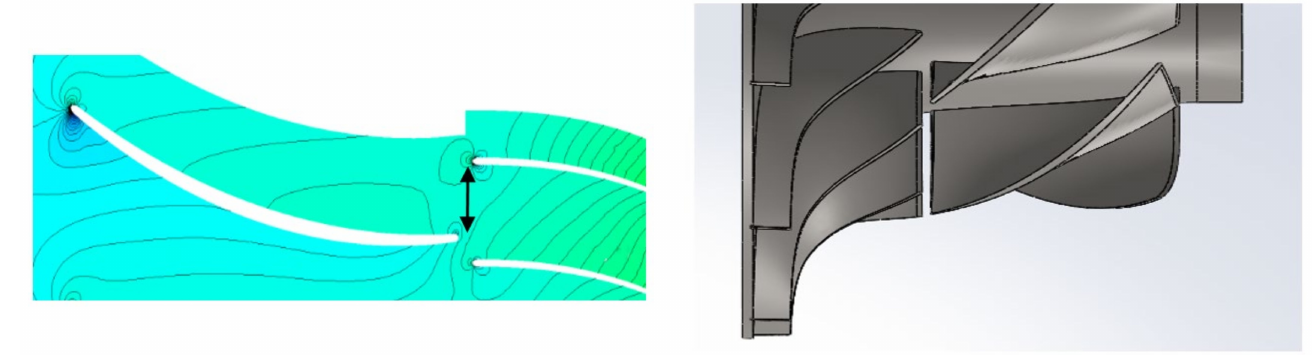
Figure 19. Graphical representation of “clock” ( left ) and “clearance” ( right ).